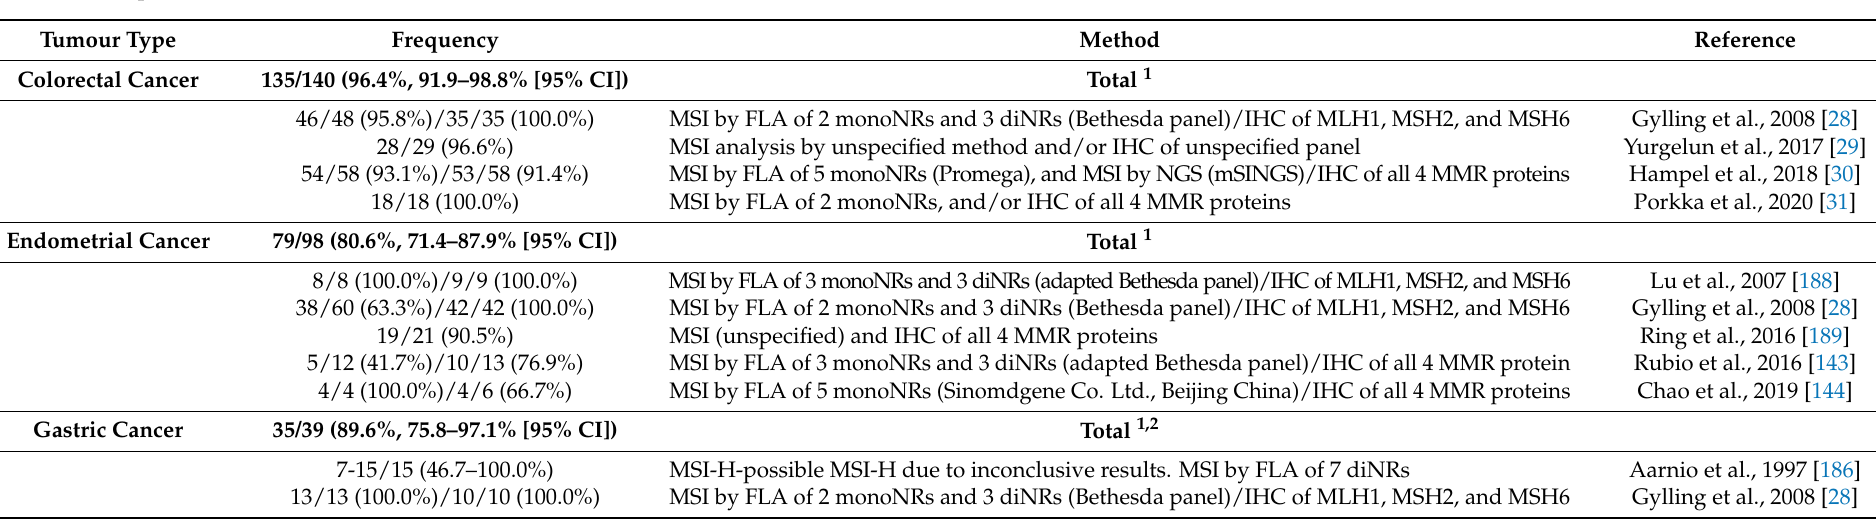
Table 2. Estimated frequency of mismatch repair (MMR) deficiency in different tumour types from Lynch syndrome (LS) gene carriers. Studies were only included if the LS diagnosis was made independent of tumour MMR